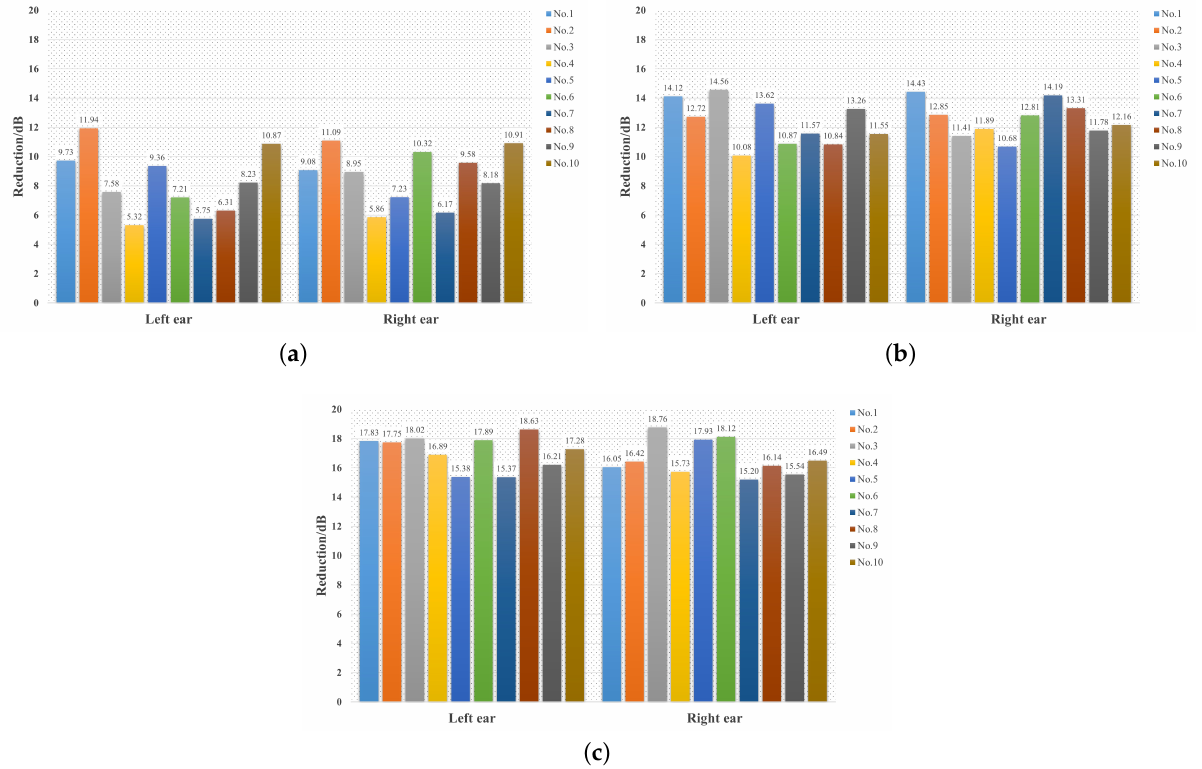
Figure 9. Noise reduction levels at the left and right ears of 10 participants. ( a ) Performance of fixed headrest structure. ( b ) Performance of movable microphone structure. ( c ) Performance of the proposed adjustable